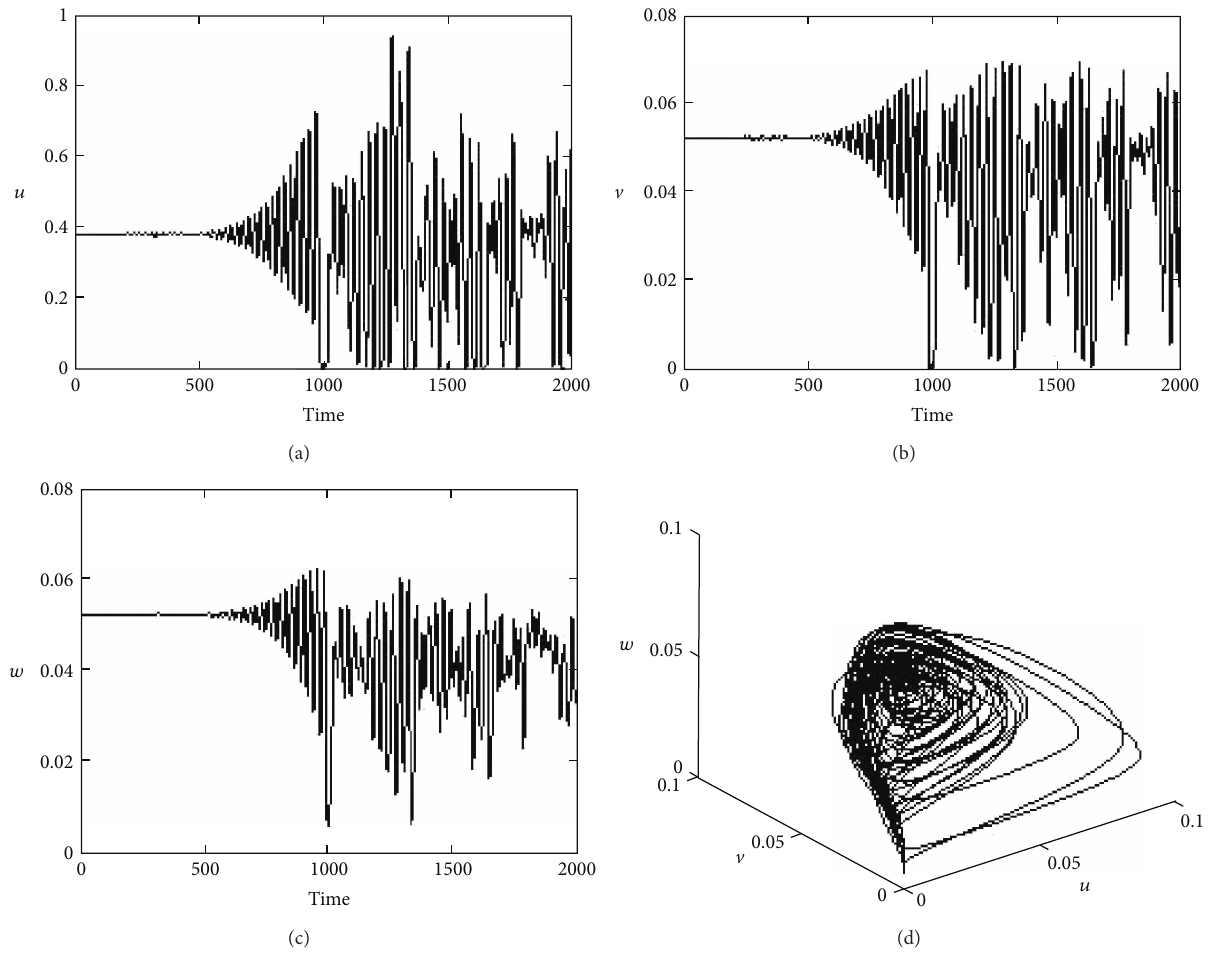
Figure 6: Dynamical behaviors of model (3). (a) Time-series plot of 𝑢 , (b) time-series plot of V , (c) time-series plot of 𝑤 ; (d) phase portrait. The parameters are the same as those in Figure